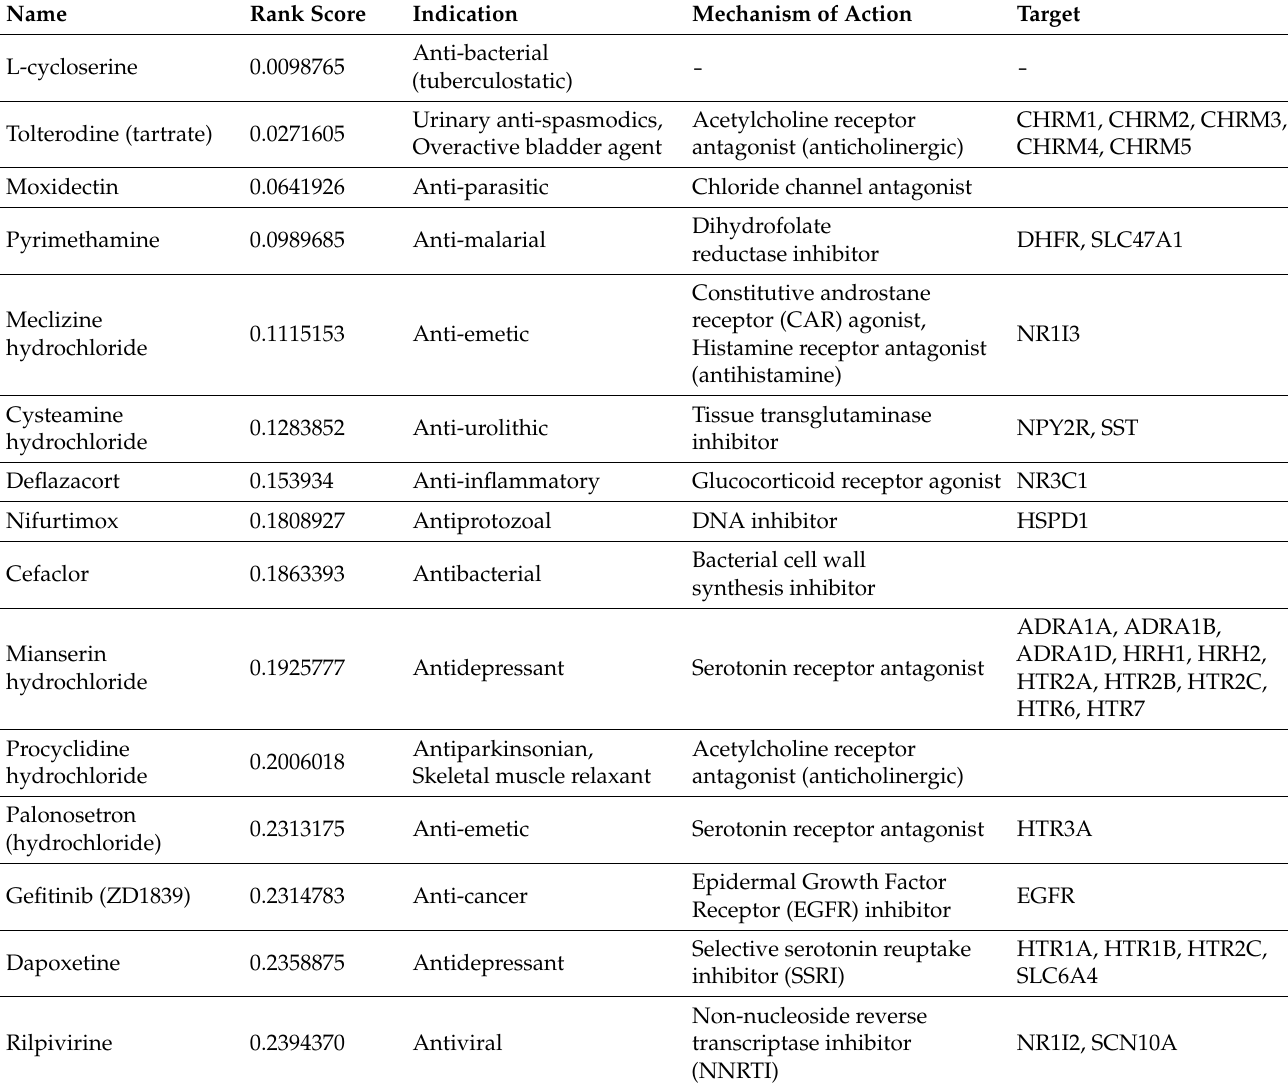
Table 2. Top 15 drugs that passed all the filters showing their activity rank score against SARS- CoV-2 (with a lower score showing greater activity), original indication, mechanism of action, and associated